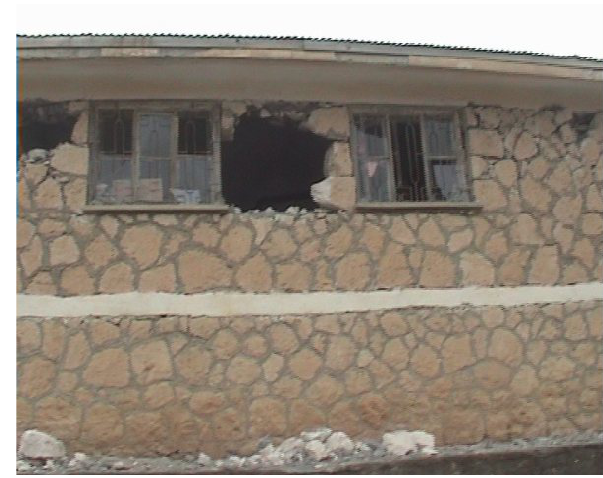
Fig. 8. Short distance between two